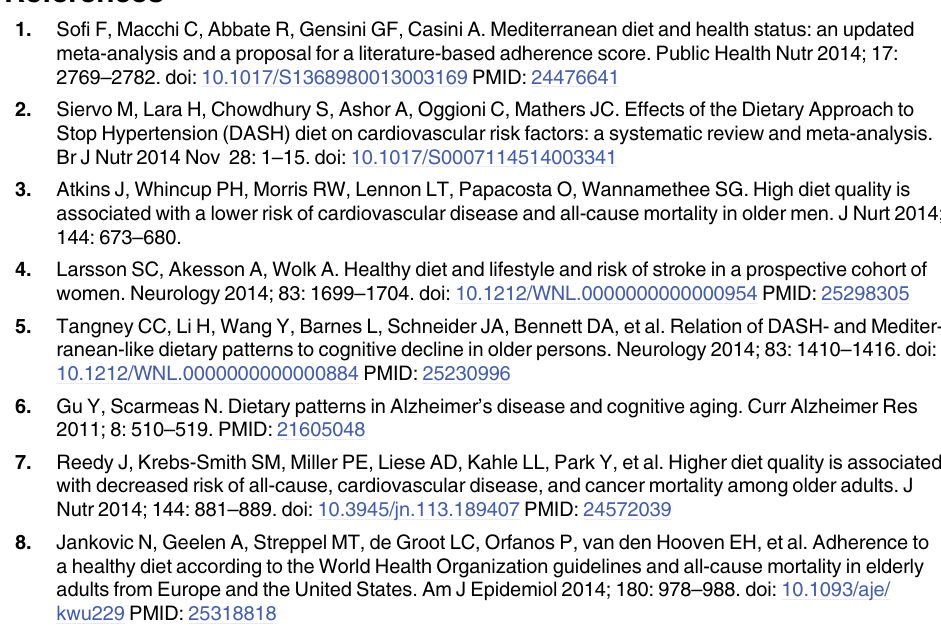
S3 Table. Major baseline chronic diseases by dietary patterns. S4 Table. Socioeconomic determinants of dietary pattern membership in community- dwellers. S5 Table. Selected studies of older adults reporting inverse relationship between DP derived a posteriori and SES